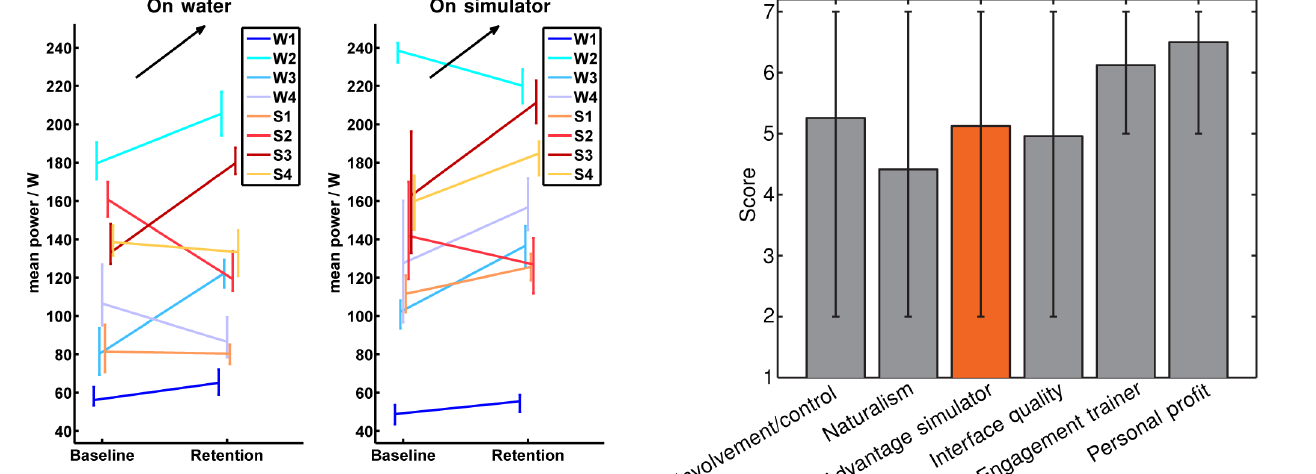
(Table 4: row: ‘‘overall impression’’, columns ‘‘D’’; compared to Table 1: last row).